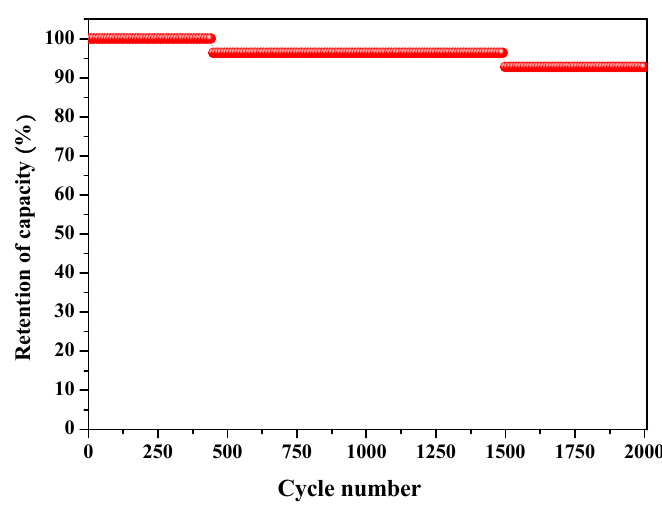
Figure 6. Electrochemical cyclic stability analysis of ACP-1100 at a current density of 5 A g − 1 .